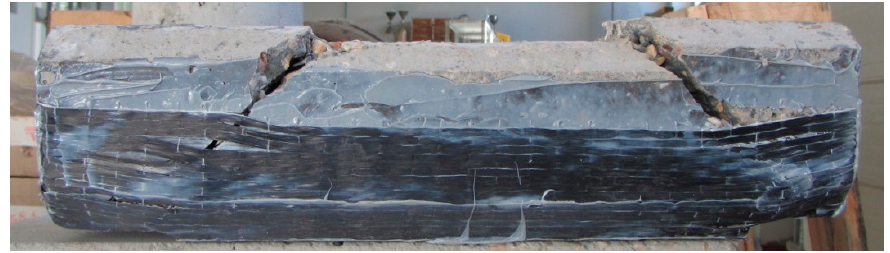
Figure 5. Fracture pattern of the prismatic specimen.